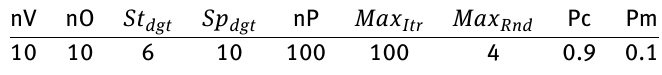
Table 33: VSSCGA Settings for Interval arithmetic benchmark problem nV nO St dgt Sp